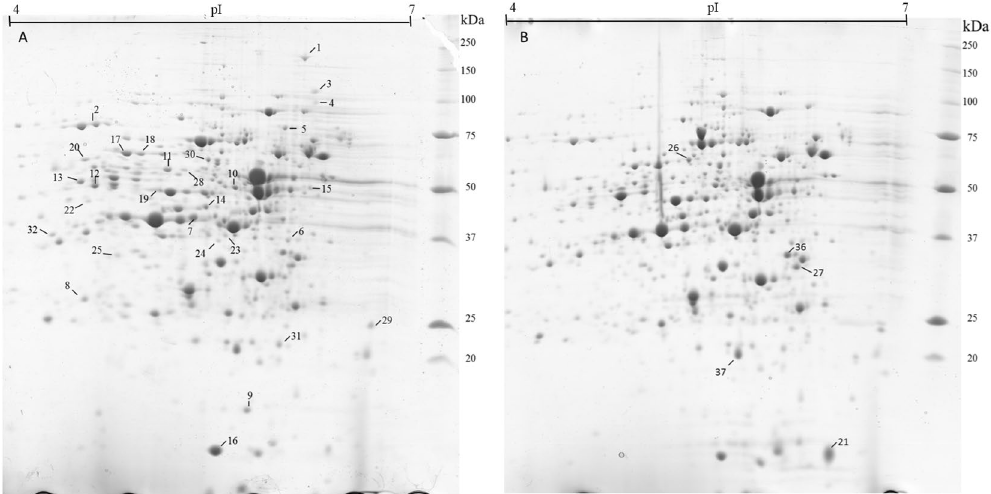
Figure 2. Two-dimensional gels (pH 4 to 7) of the cytoplasmic proteins of L . delbrueckii subsp. lactis CRL 581 grown in CDM ( A ) and CDM plus Casitone ( B ). Gels were stained with Coomassie Brilliant Blue G-250. The protein spots which are differentially regulated in CDM or CDM plus Casitone are indicated. The Precision Plus protein Standard (Bio-Rad) was used as